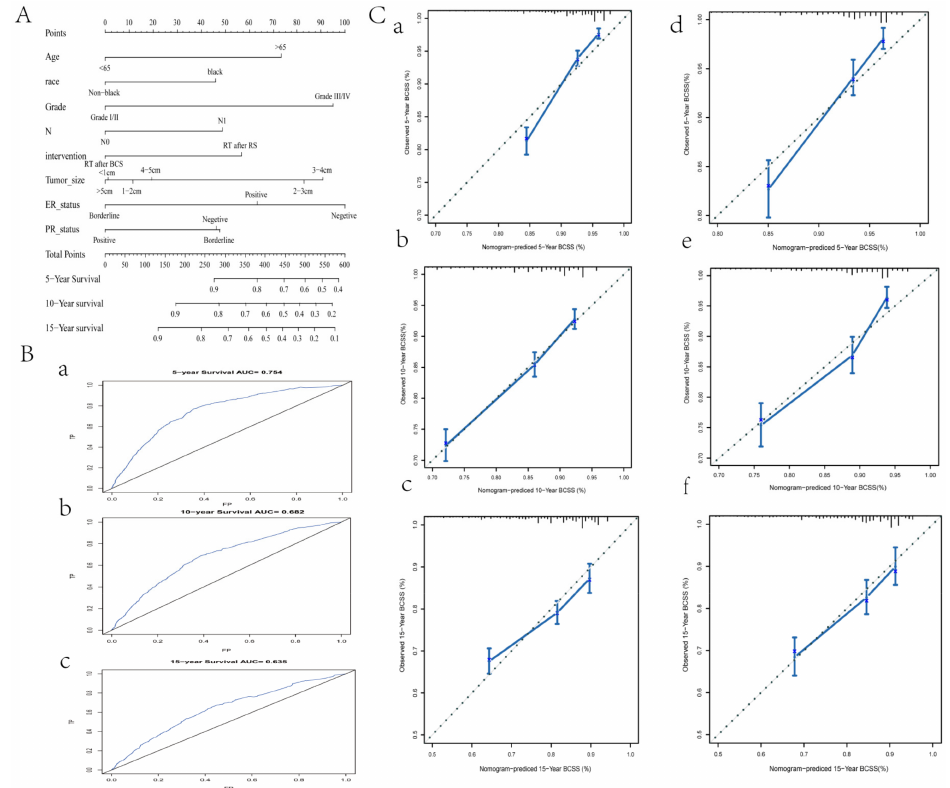
Figure 4. Prediction and validation of the nomogram in stage II patients. ( A ) The nomogram for the 5-, 10-, and 15-year BCSS prediction of stage II patients. ( B ) ROC curves verified the predictive